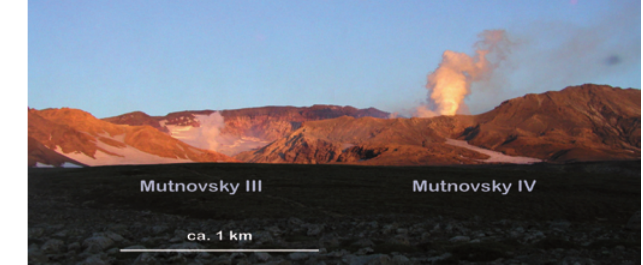
Figure 2. Mutnovsky Volcano from the west. The Crater Glacier and the hydrothermal plume of Mutnovsky III crater is visible through the breach formed by the Volcannaya River in Dangerous Ravine left of center. The larger plume from the Active Crater of Mutnovsky IV rises to the right. Width of the field of view is approximately 3 km (photo by J.